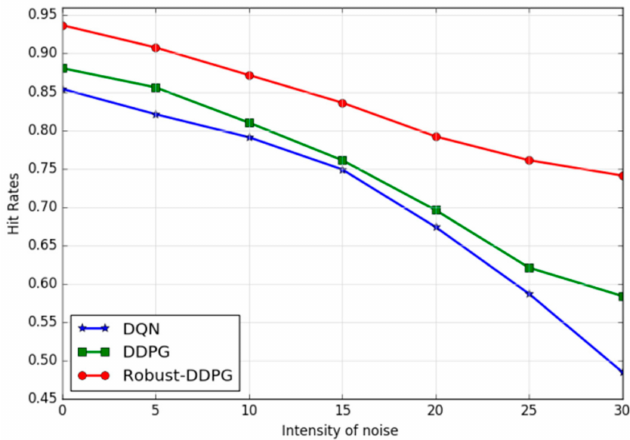
Figure 12. Trends of hit rates under di ff erent noise intensities of the three